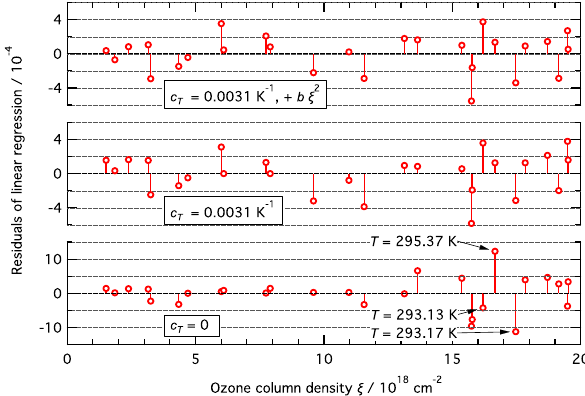
Figure 4. Unweighted linear fit to 27 individual pairs of ozone op- tical ( τ ) and column ( ξ = n · L ) densities.